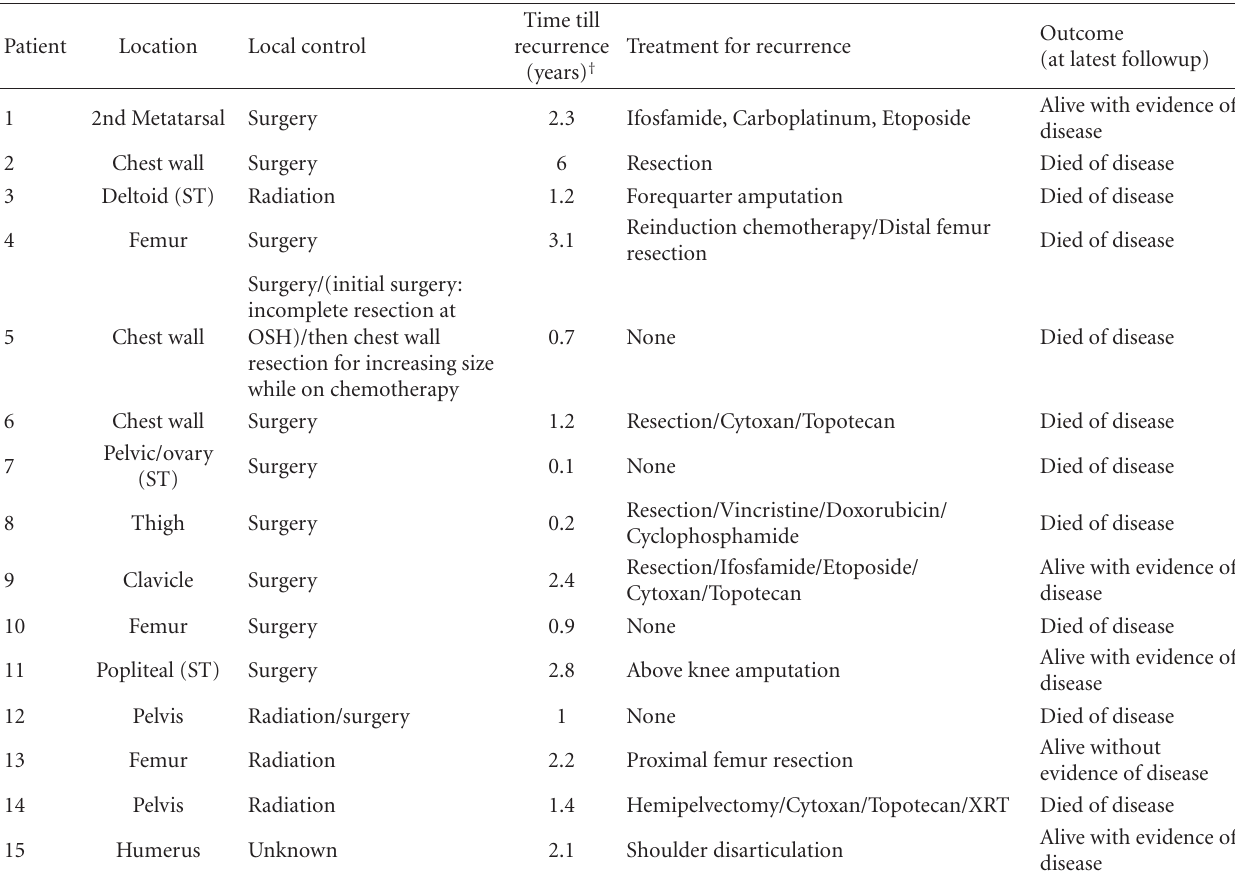
† : Time to recurrence calculated from date of diagnosis. ST: soft tissue